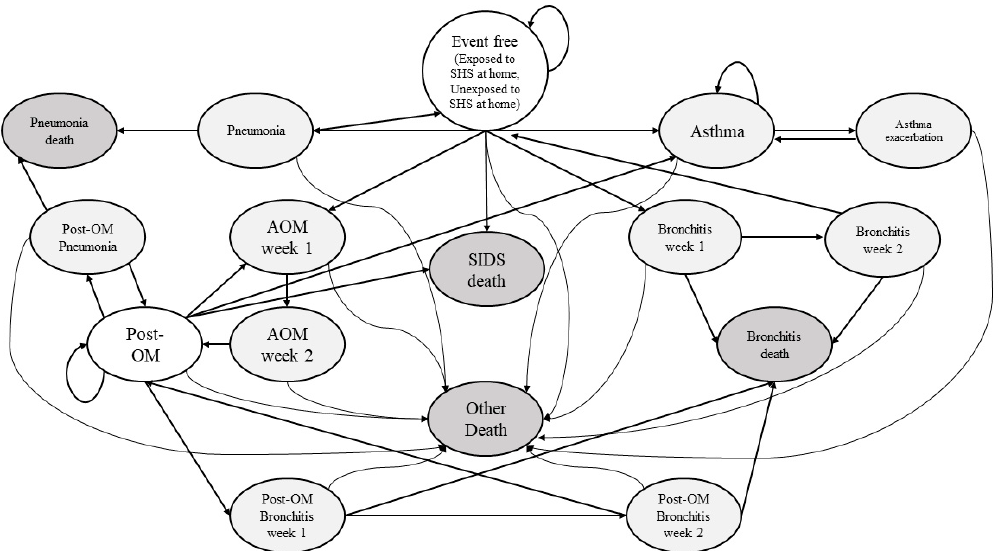
Figure 1. Health states and disease progression of Korean children who were exposed to SHS at home. SIDS, sudden infant death syndrome; AOM, acute otitis media; Post-OM, post-otitis media; SHS, secondhand smoke.